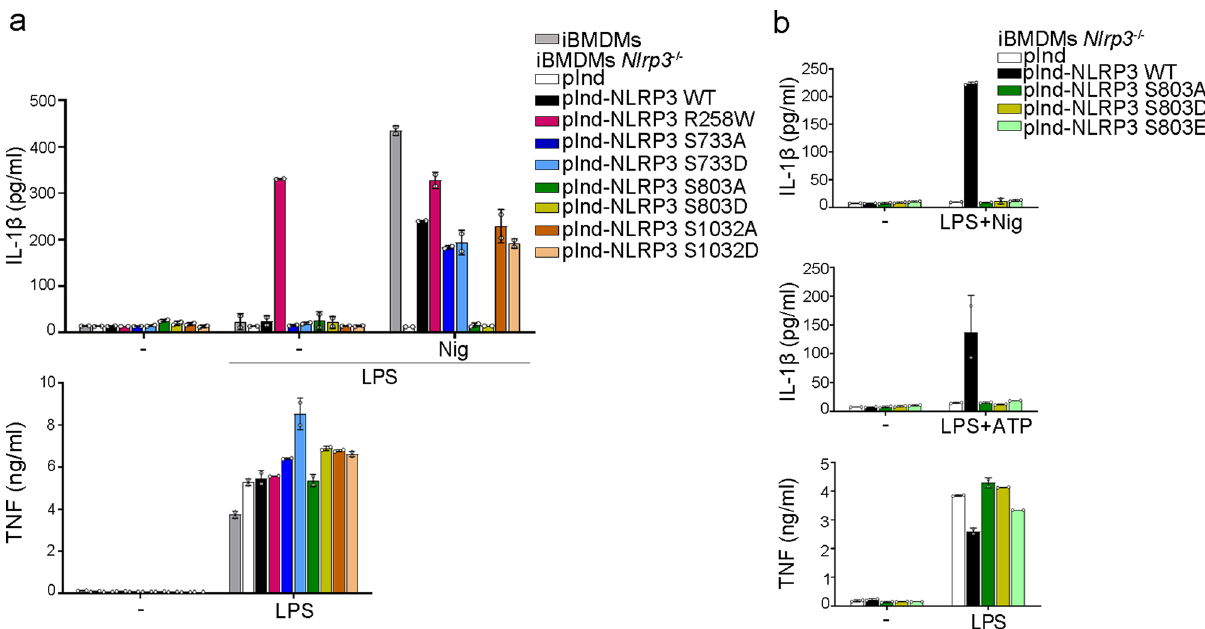
Fig. 3 S803 is critical for NLRP3 in fl ammasome activity in immortalized BMDMs. a , b Immortalized WT and Nlrp3 − / − BMDMs reconstituted with doxycycline-inducible NLRP3 mutants were sequentially treated with doxycycline, LPS, and nigericin or ATP as indicated. IL-1 β and TNF secretions were measured by ELISA. NLRP3 R258W was used as a constitutively active control. Means and 1 SD are represented. Data are biological duplicates representative of 4 ( a ) and 3 ( b ) independent experiment. pInd pInducer21, iBMDMs immortalized